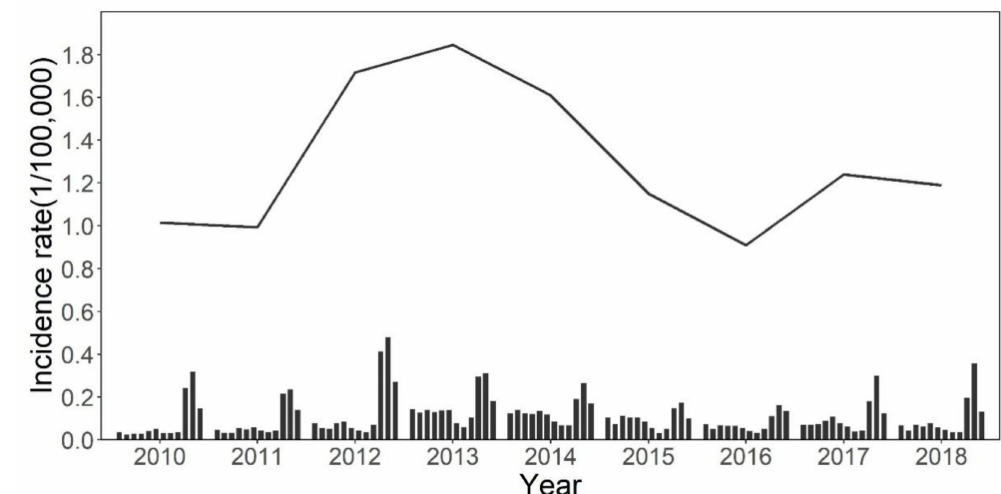
Figure 2. The temporal distribution of HFRS incidence in Shandong Province from 2010 to 2018. Solid lines and bars represent the annual and monthly incidence of HFRS in Shandong Province, respectively.